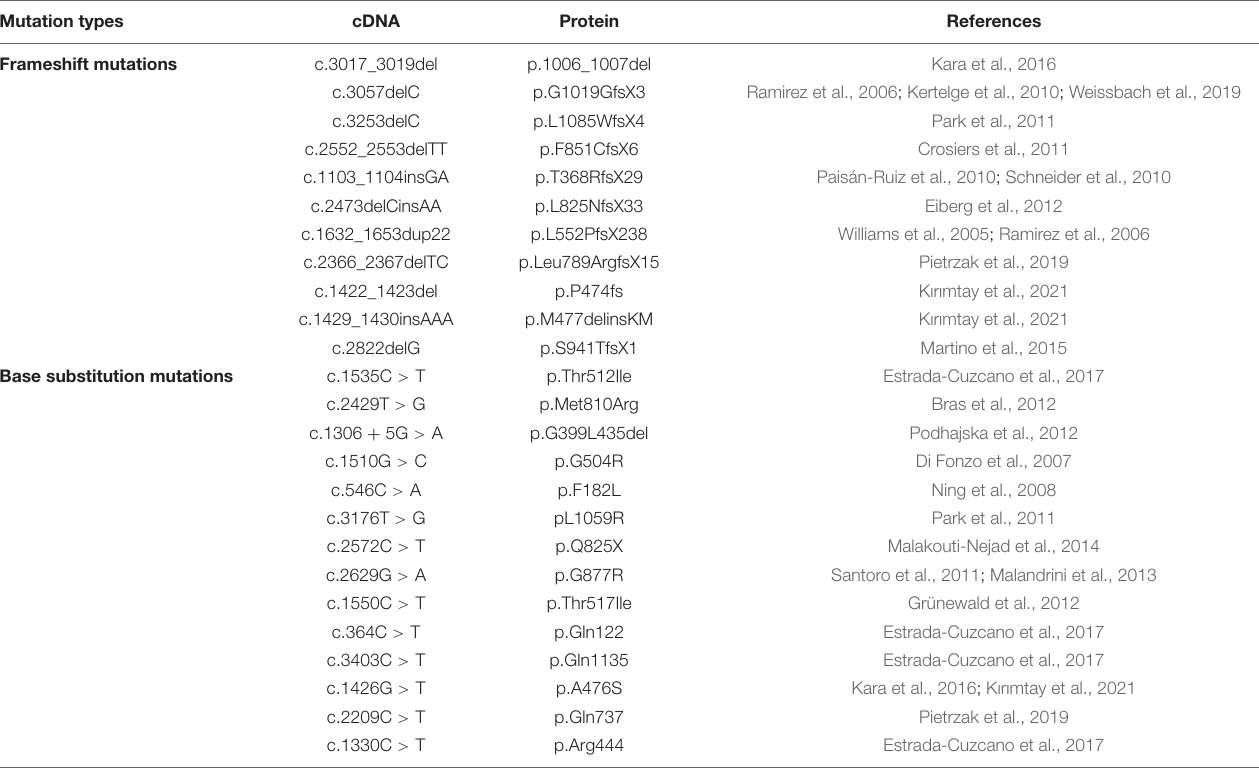
TABLE 1 | Mutation types of ATP13A2.